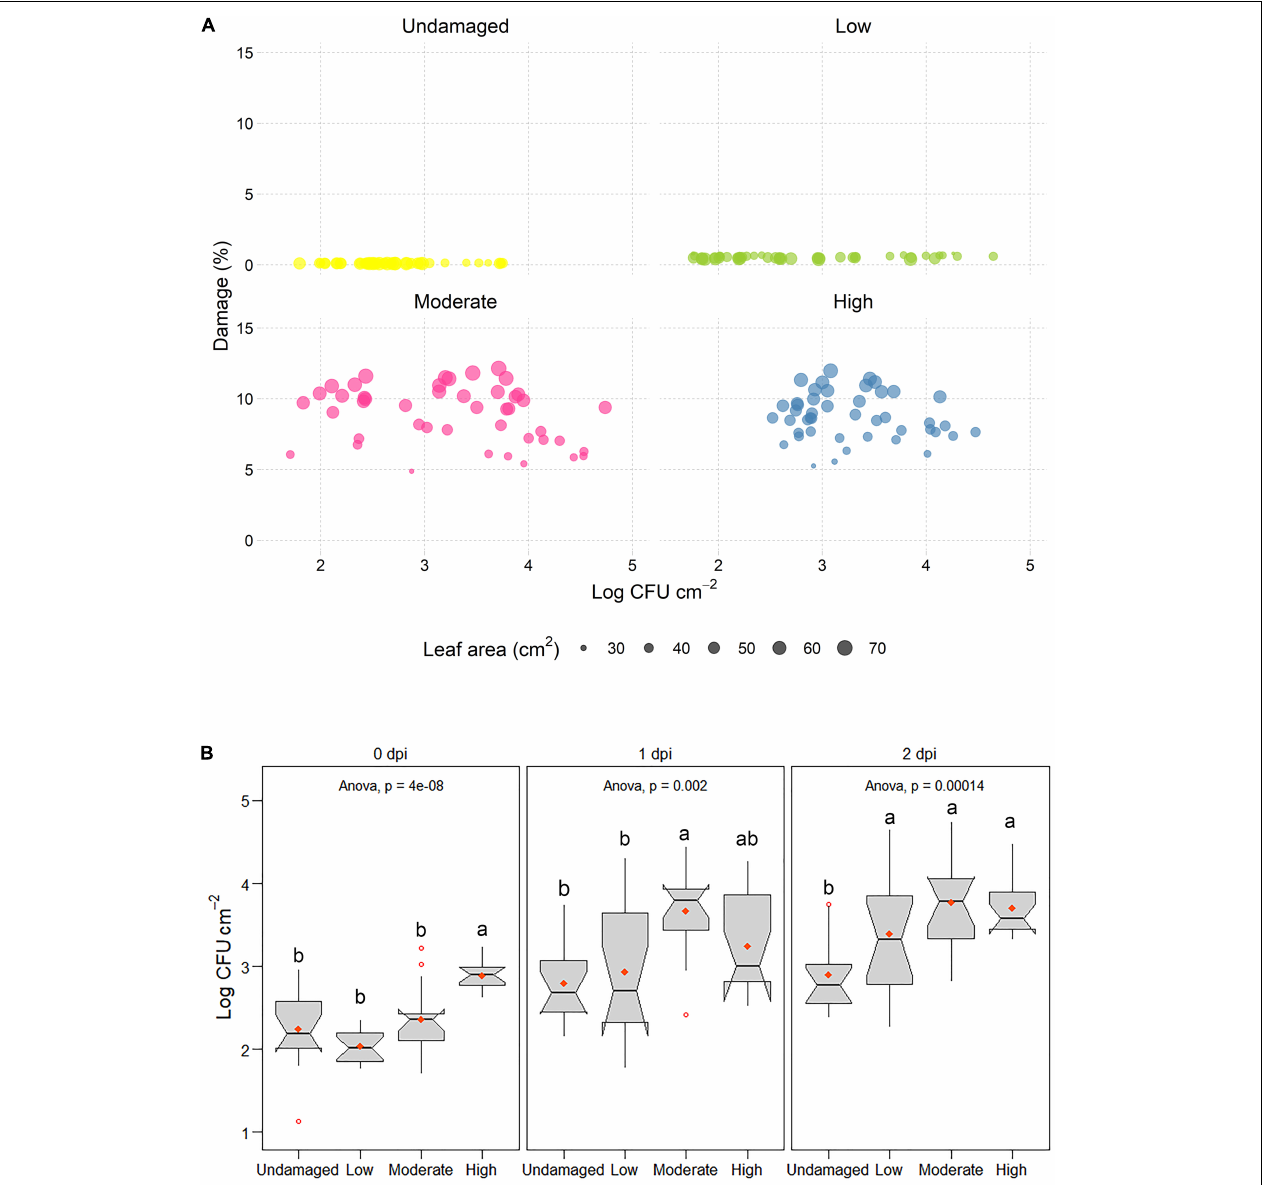
FIGURE 4 | (A) Log CFU E. coli O157:H7 gfp + × cm - 2 leaf area in leaf macerate as a function of predicted leaf damage (%). Circle size in scatter plots denotes the leaf area of E. coli O157:H7 gfp + inoculated leaves. (B) Boxplots of log CFU E. coli O157:H7 gfp + found in leaf macerate after 0, 1, and 2 dpi, calculated per cm 2 of leaf area. Different letters above boxes indicate significant differences between damage levels (Tukey, p ≤